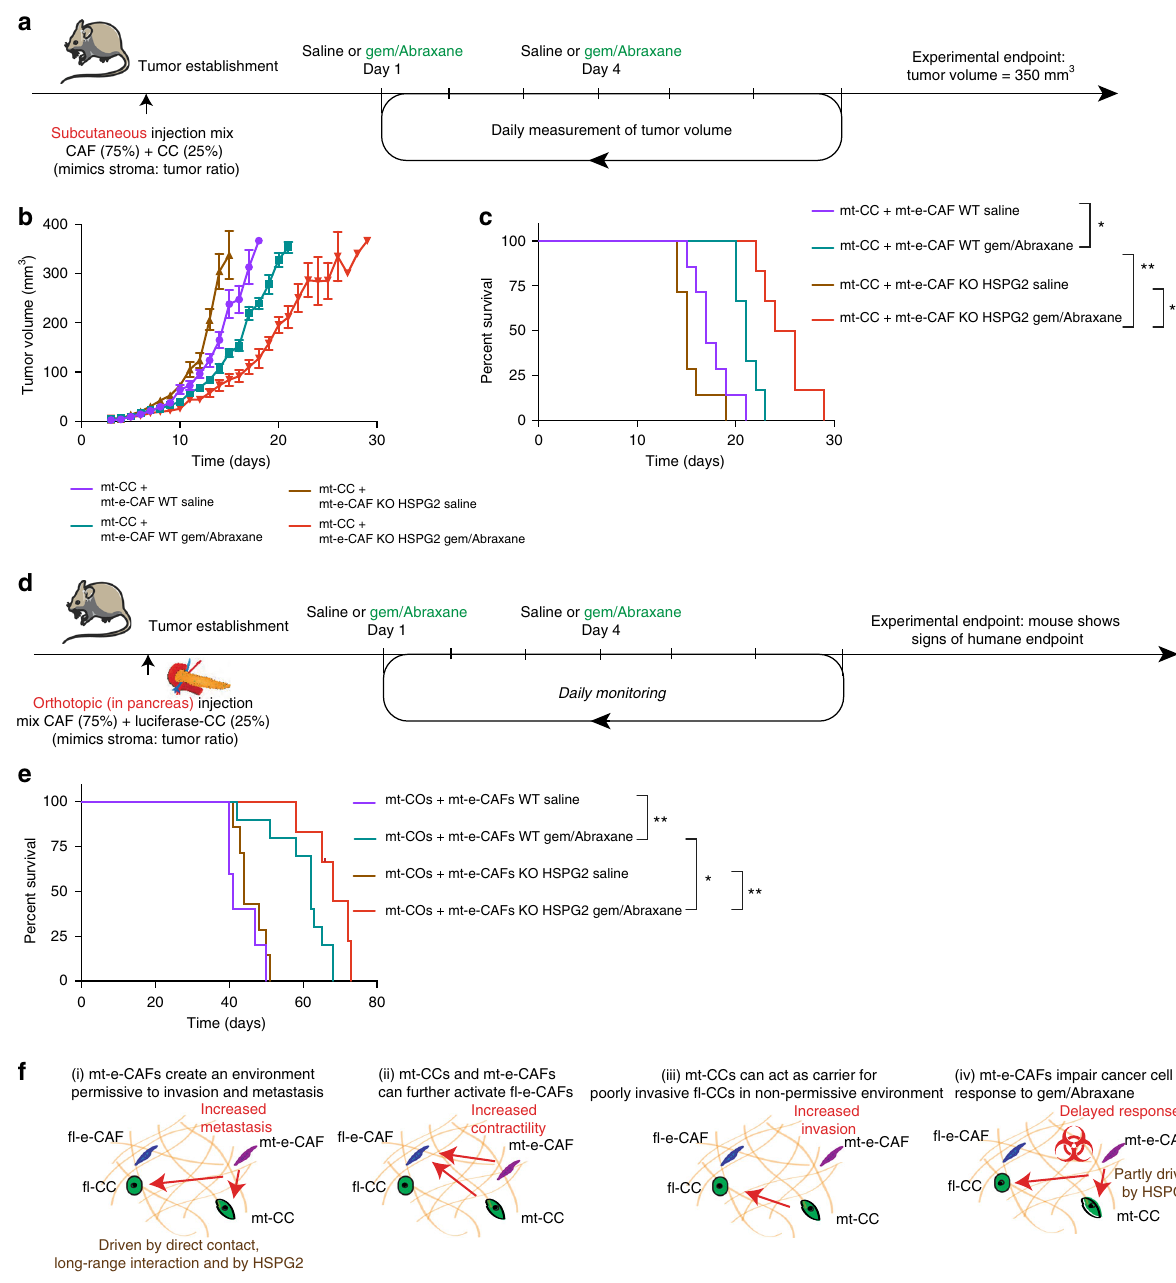
Fig. 9 Loss of HSPG2 in the stroma improves the ef fi cacy of gemcitabine/Abraxane in vivo. a Schematic representation of subcutaneous injection and treatment timeline, b quanti fi cation of tumor volume and c . time to experimental endpoint for mice subcutaneously injected with mt-CCs + mt-e-CAFs WT and treated with saline ( n = 7) or with gemcitabine/Abraxane ( n = 6) or with mt-CCs + mt-e-CAFs KO HSPG2 and treated with saline ( n = 7) or with gemcitabine/Abraxane ( n = 6). d Schematic representation of orthotopic (in pancreas) injection and treatment timeline, and e survival for mice orthotopically injected with mt-COs + mt-e-CAFs WT and treated with saline ( n = 5) or with gemcitabine/Abraxane ( n = 10) or with mt-CCs + mt-e- CAFs KO HSPG2 and treated with saline ( n = 7) or with gemcitabine/Abraxane ( n = 5). f Schematic summary of main fi ndings. * p < 0.05, ** p < 0.01, *** p <